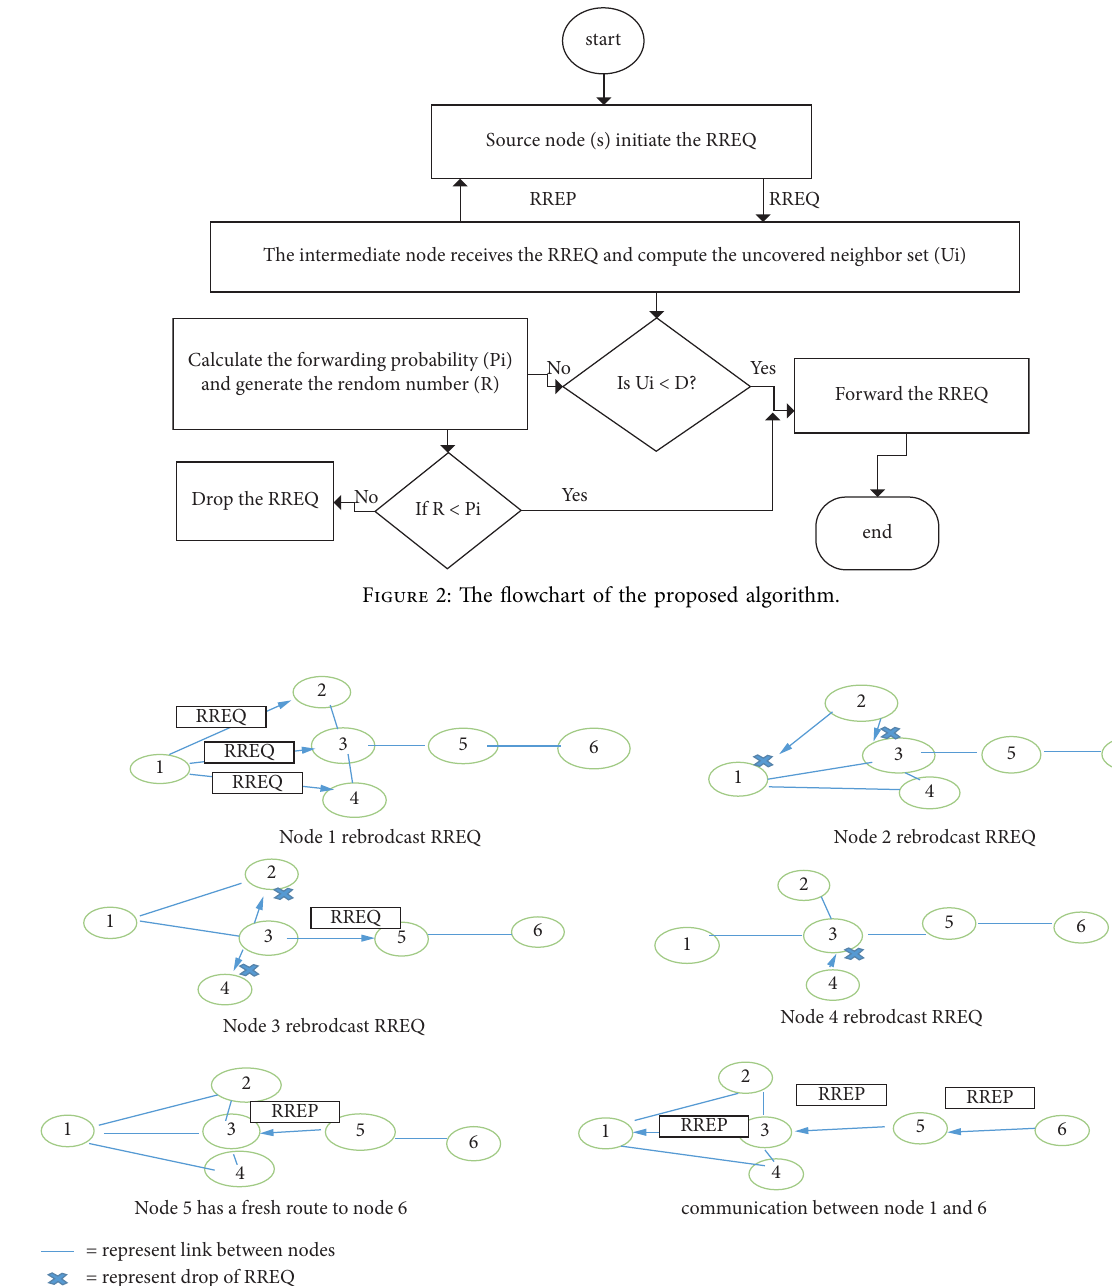
Figure 3: AODV RREQ